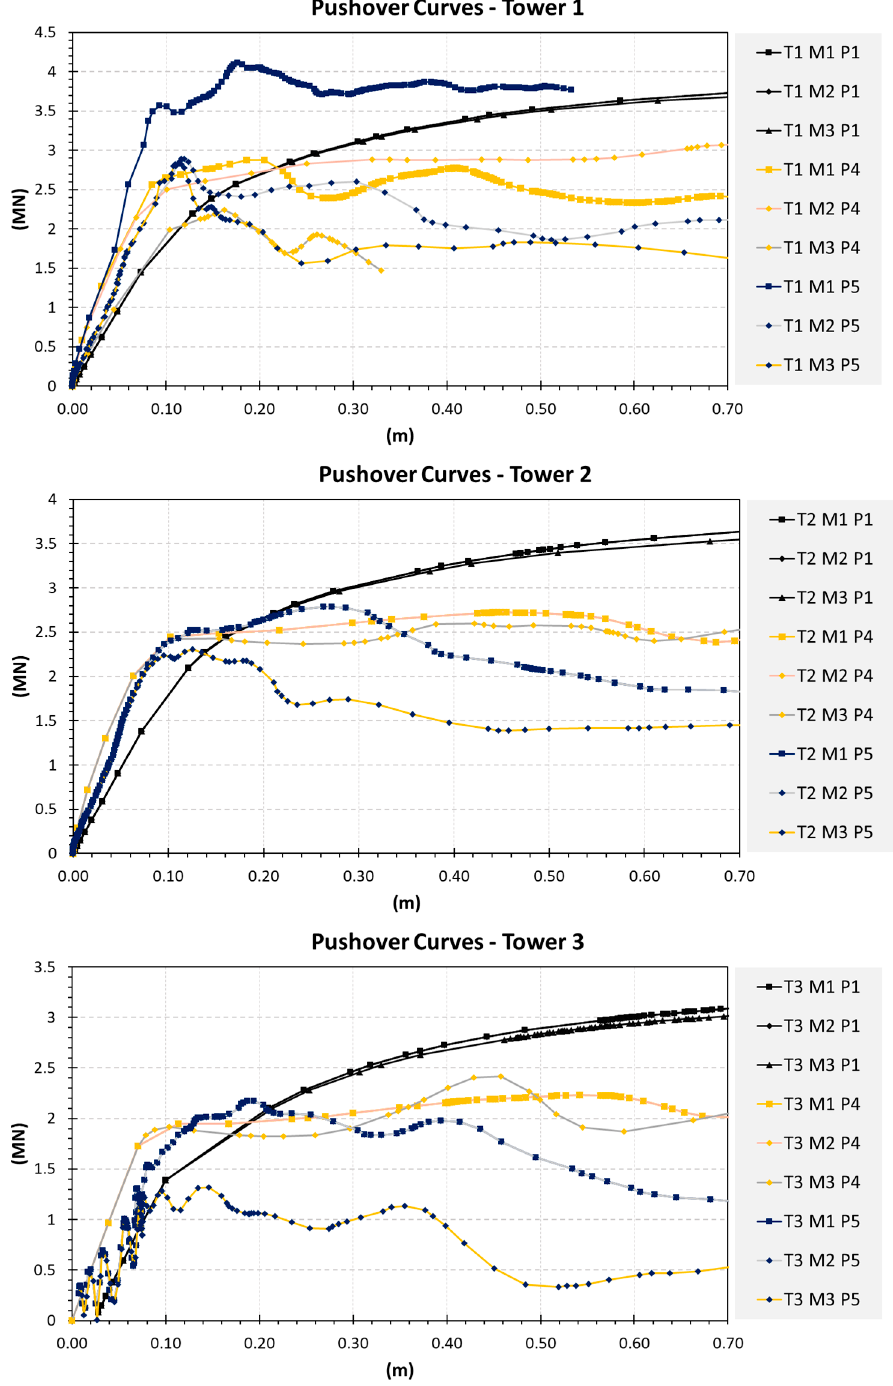
Figure 7. Pushover capacity curves under P1, P4 and P5 load patterns for (top to bottom) Tower 1, Tower 2 and Tower 3 respectively